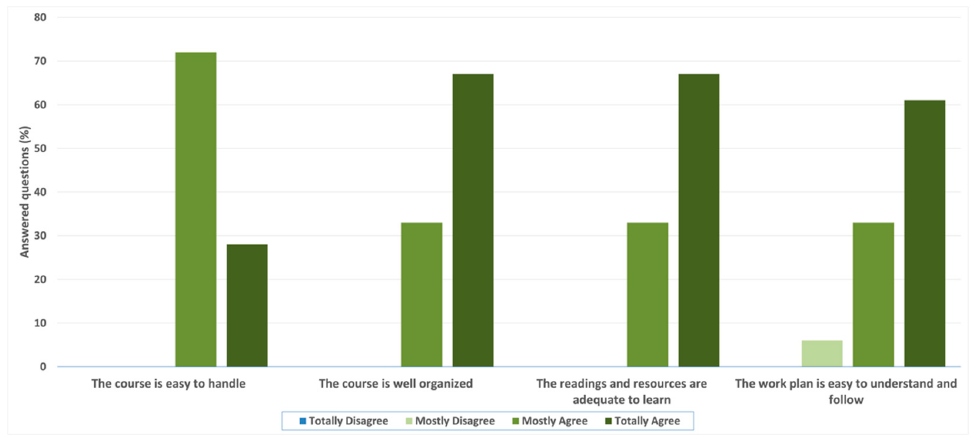
Figure 2. Participant’s answers to Question #1—“Indicate your level of agreement with the follow